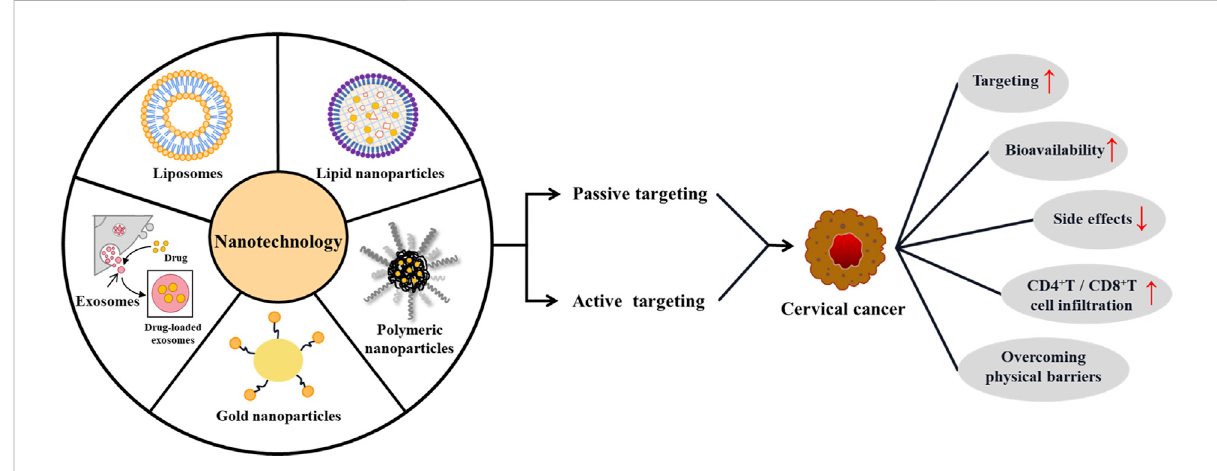
FIGURE 2 Nanotechnology-mediated immunotherapy for cervical